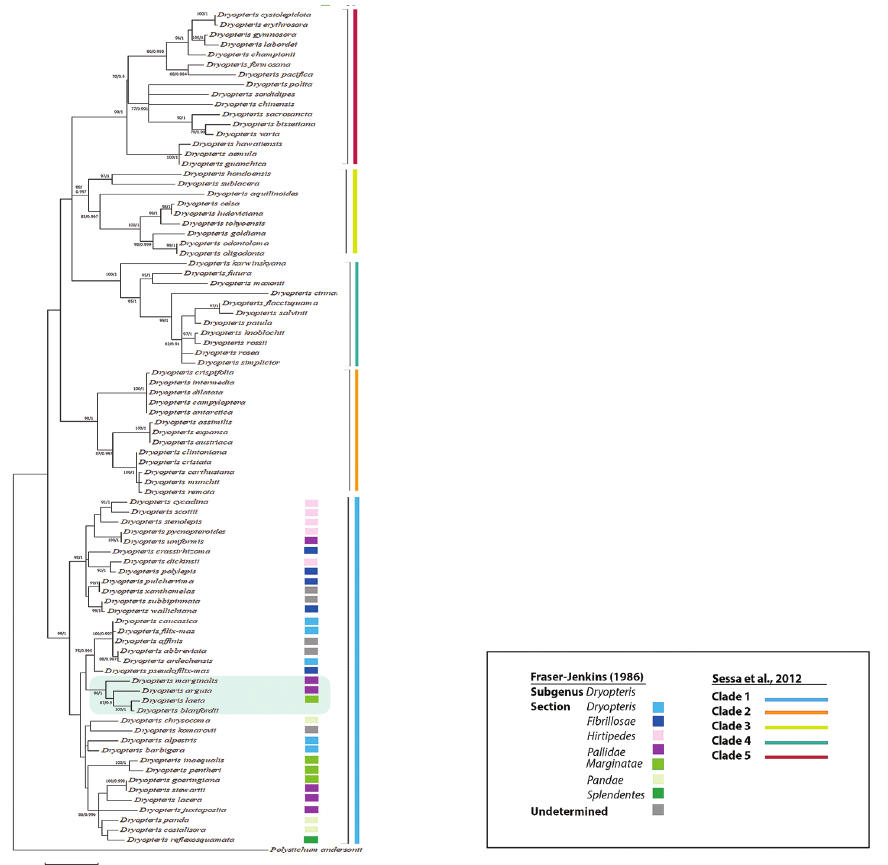
Figure 2. Topology from ML and BI analyses of Dryopteris species using six marker regions consisting of 3734 total bases ( psbA-trnH , rbcL-accD, rbcL , trnL-trnF, trnP-petG , rps4-trnS and matK ). The tree is drawn to scale, with branch lengths measured in the number of substitutions per site. Bootstrap values are specified at the branch nodes (cut off >50%) / Bayesian РР . Dryopteris blanfordii subsp. nigrosquamosa and closely related species are marked with a blue